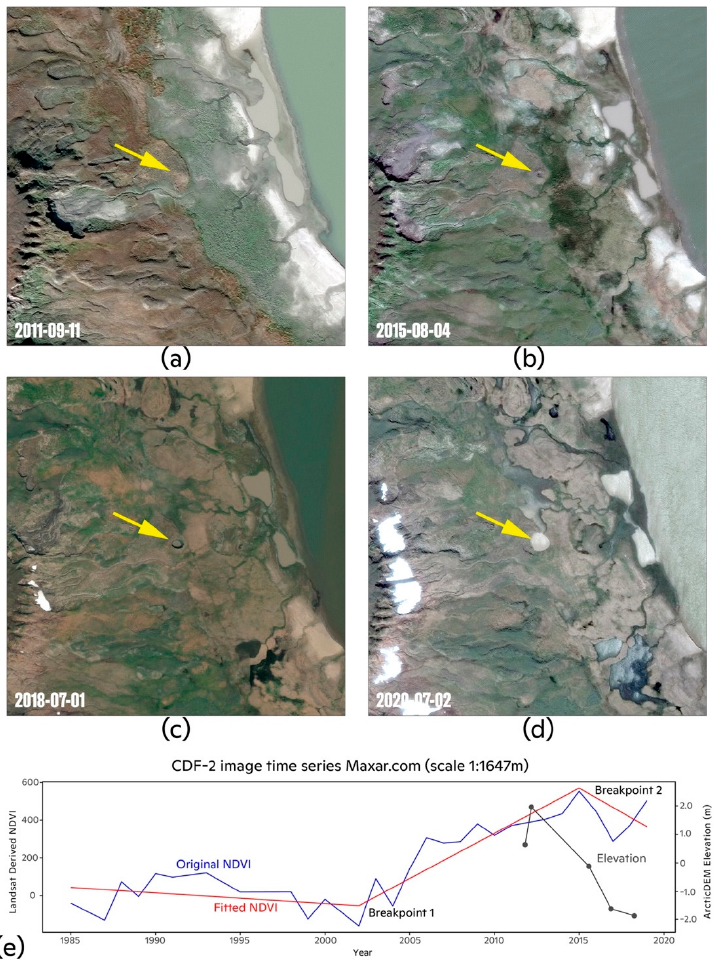
Figure 7. Time-series of high-resolution satellite imagery showing the development of CDF-2 from September 2011 (top left image) to July 2020 (bottom right image). Image series shows the mound predecessor ( a ), mound degradation ( b ), crater formation ( c ), and subsequent lake expansion ( d ). Graphs at the bottom ( e ) show the original trends and fitted trends (by LandTrendr) in Landsat-derived NDVI (left) (scaled from − 1000 to 1000), breakpoints identi fi ed by LandTrendr, and trends in elevation (right; 2014–2017) extracted from the corrected ArcticDEM strips. Imagery © 2020, DigitalGlobe.